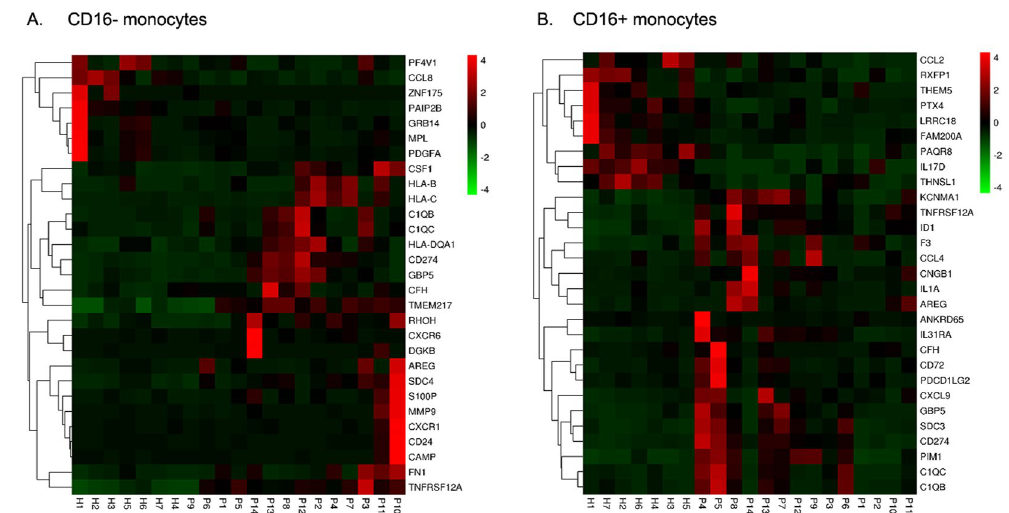
Figure 5. The heatmap of genes involved in signal transduction expressed by CD16 − and CD16 + monocytes. The transcriptional profiles were apparently differently between the health (H1 to H7) and the T-NHL patients (P1 to P14) both in CD16 − ( A ) and CD16 + monocytes ( B